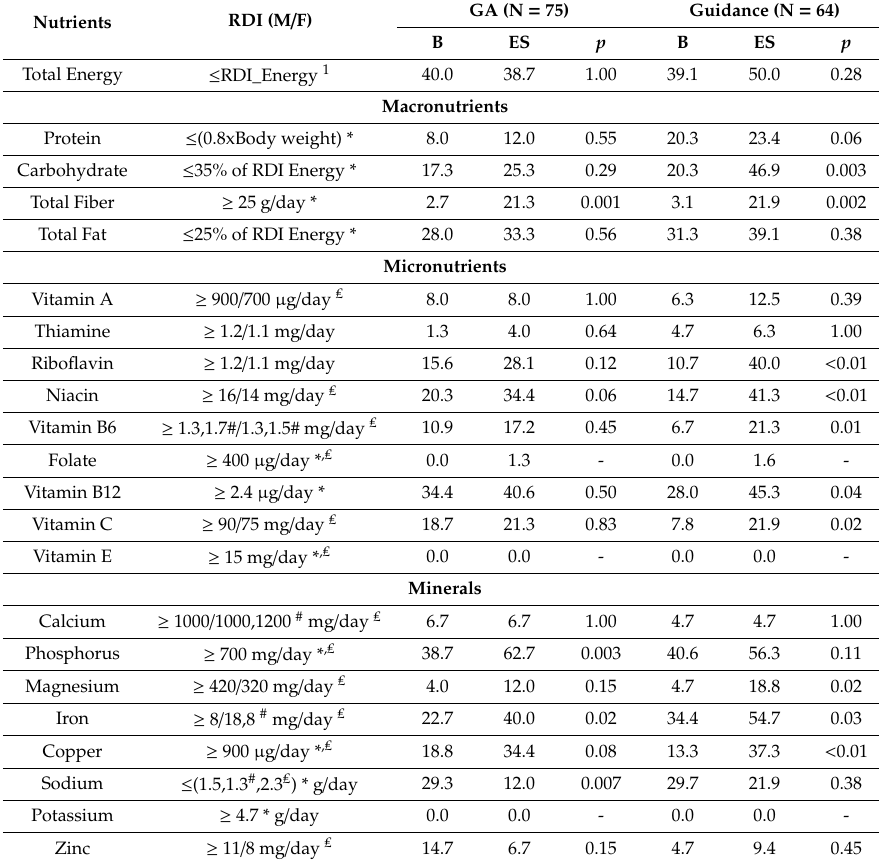
Table 4. Percentage changes in recommended dietary intakes in the two study